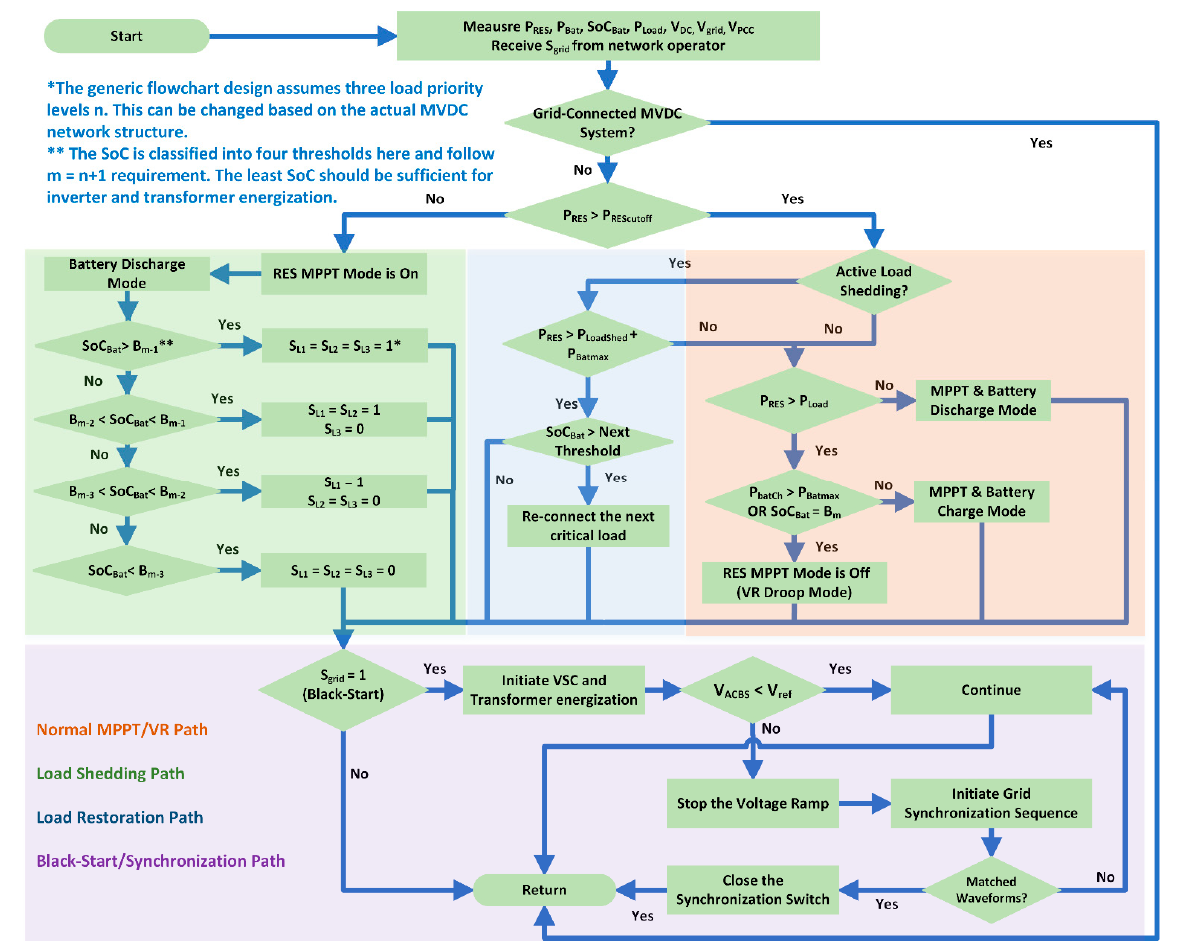
Figure 2. Detailed energy management system (EMS) design flowchart with multiple operating modes.